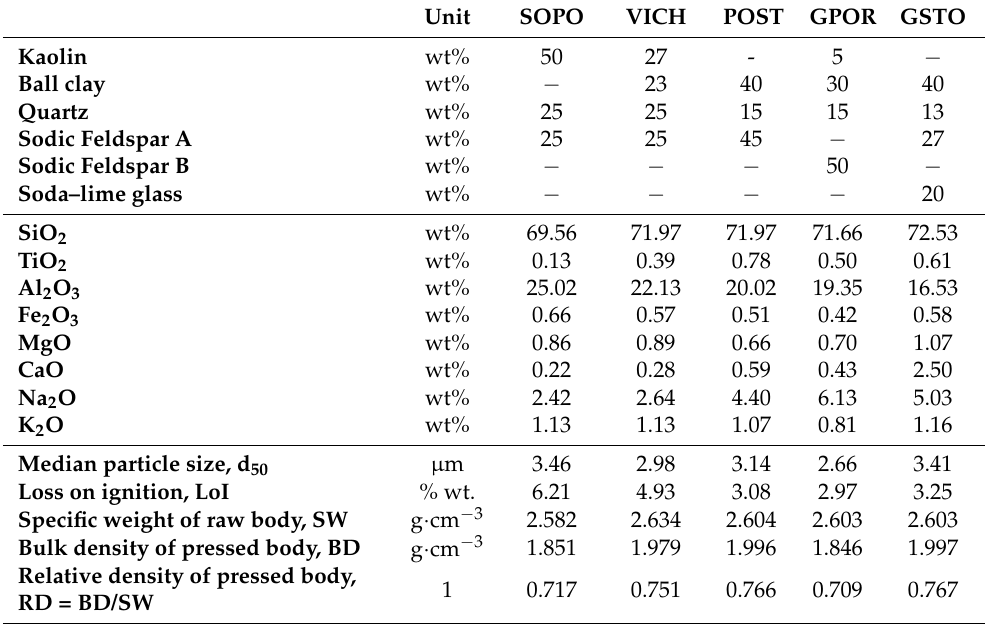
Table 2. Formulation, chemical composition and main physical properties of the raw